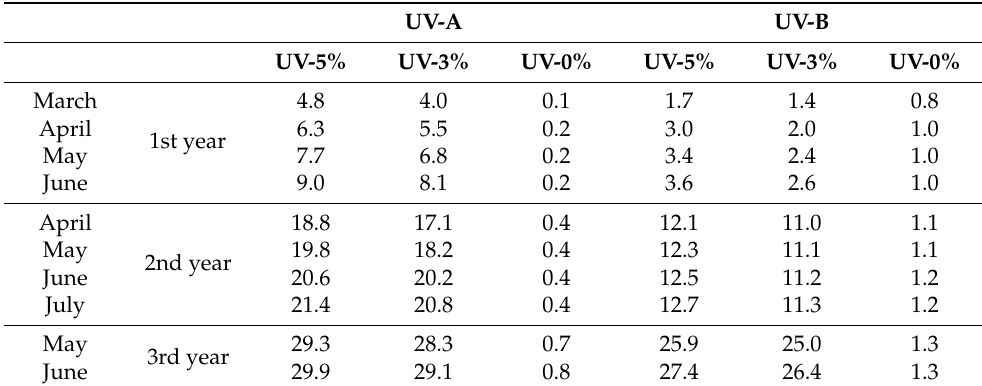
Table 1. Cover transmissivity (%) of UV radiation for A and B wavebands.